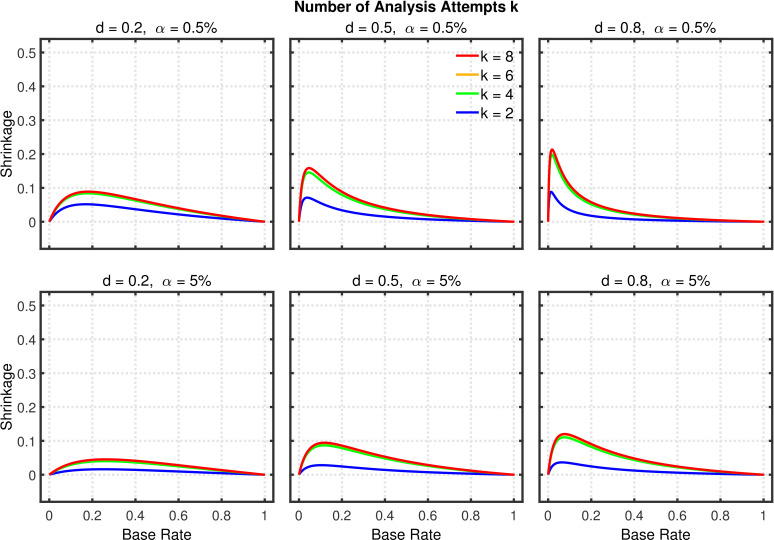
Selective outlier removal.Shrinkage of the replication rate (i.e., the difference between the solid and dashed lines in Figure 13—figure supplement 2) as a function of base rate π, number k of outlier rejection methods attempted, effect size d, and nominal α level (0.5% or 5%). Simulated data included no outliers.